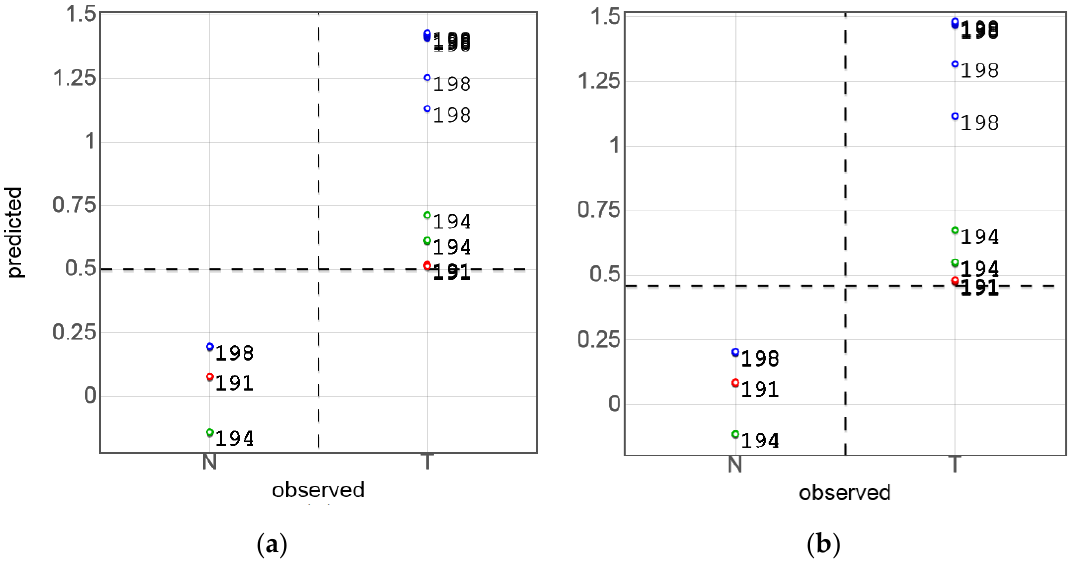
Figure 6. Partial least-squares discriminant analysis (PLS-DA)-predicted (sample-based segmented cross-validation (CV)) vs histologically observed tumor discrimination in Series A samples (patient ID numbers are indicated): ( a ) near-infrared (NIR) spectra, and ( b ) simulated sensor data. In the next development step, the full-spectrum data were used for sensor simulations. To simulate the sensor data, the spectral variables in the analytical regions were averaged using the real